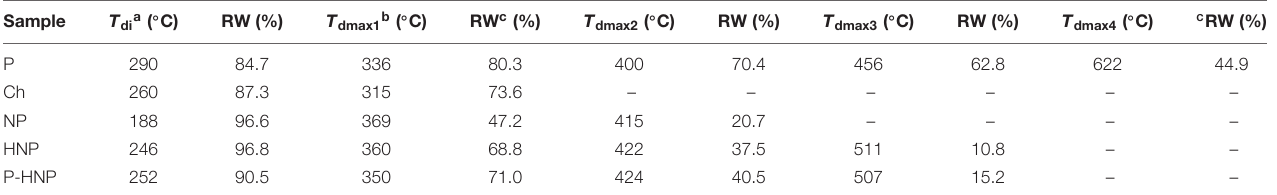
TABLE 3 | Thermogravimetric data of the porphyrin ( P ), chitosan ( Ch ), nanostructured particles ( NP ), hybrid nanoparticles ( HNP ), and hybrid nanoparticles with porphyrin ( P-HNP ).